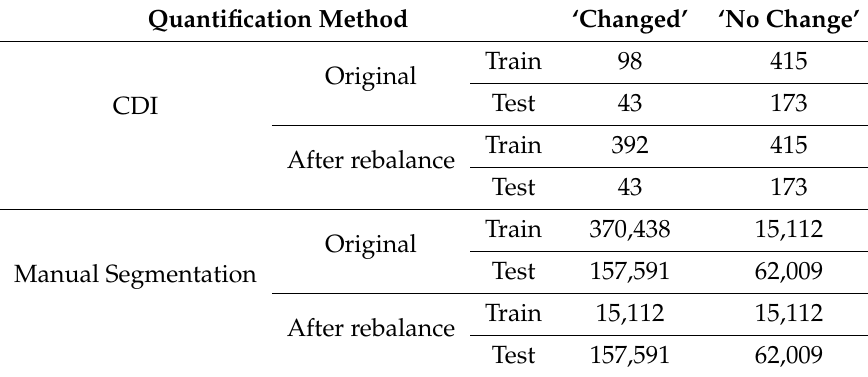
Table 7. Sample distribution in experiment